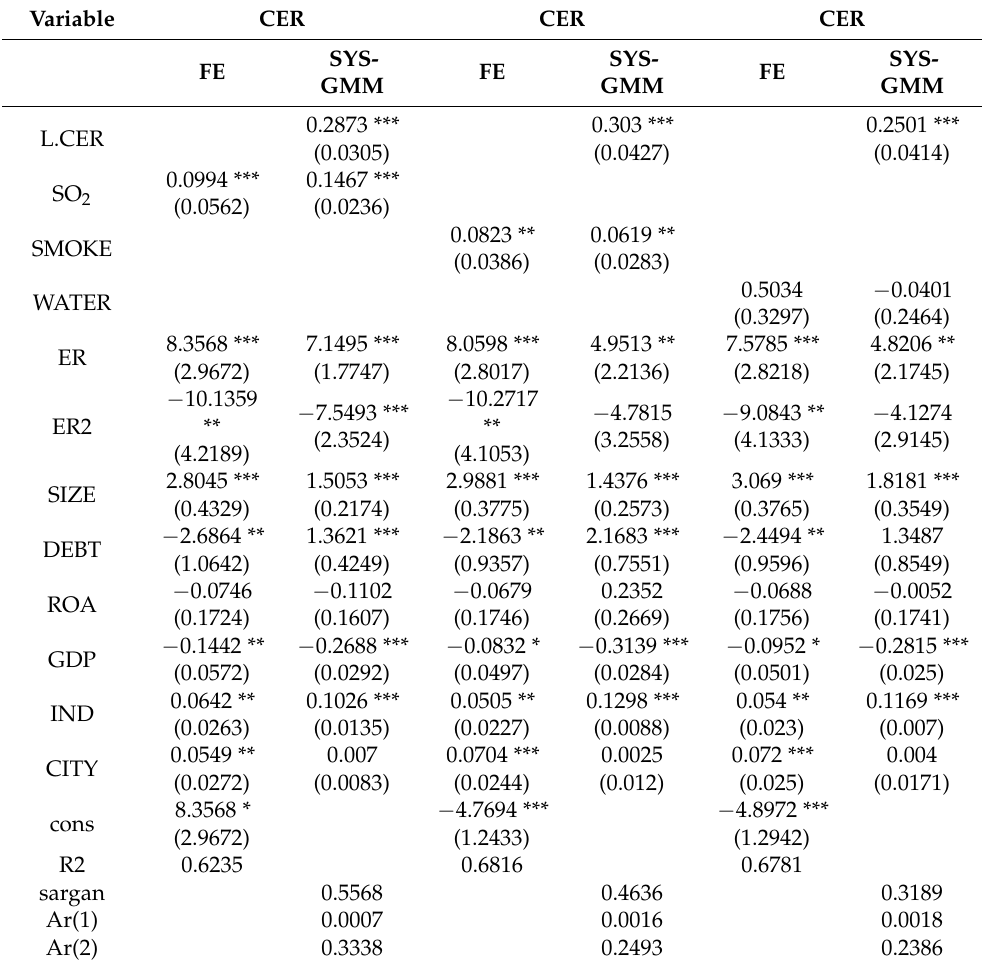
Table 6. Regression results of environmental regulation and environmental pollution on